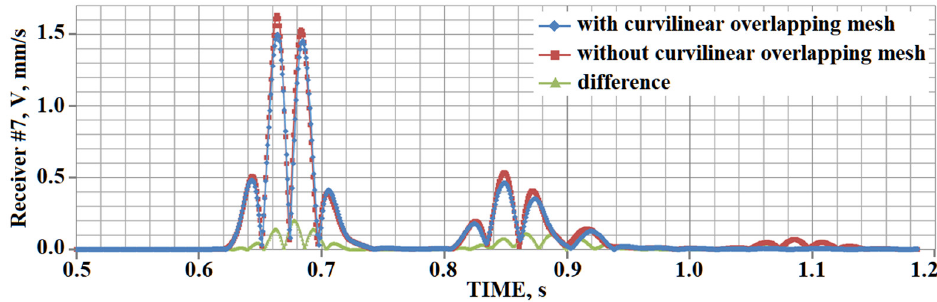
Figure 15. Receiver #7, dependencies of velocity modulus on time.